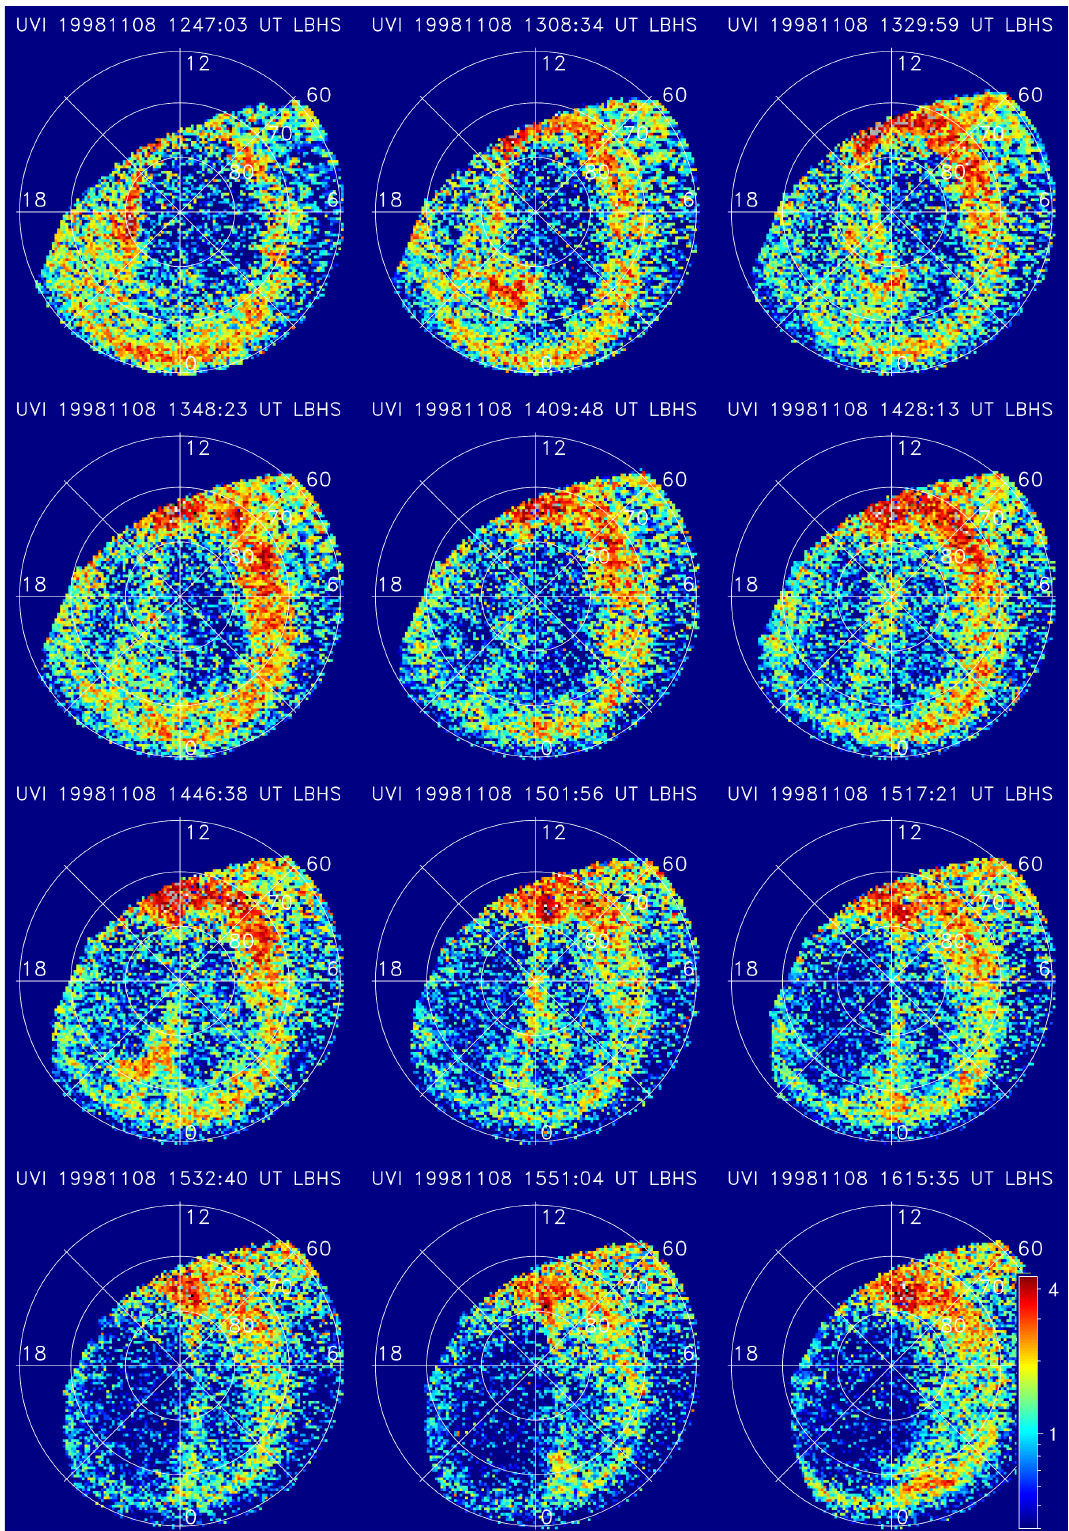
Fig. 2. On 8 November 1998, the Polar UVI instrument provides images in the Northern Hemisphere taken with the LBHs filter at a 3-s integration period and plotted in magnetic apex latitude and magnetic local time. False colour images of the aurora are shown, with a log colour scale extending from 0.4 to 4.5kR. See text for